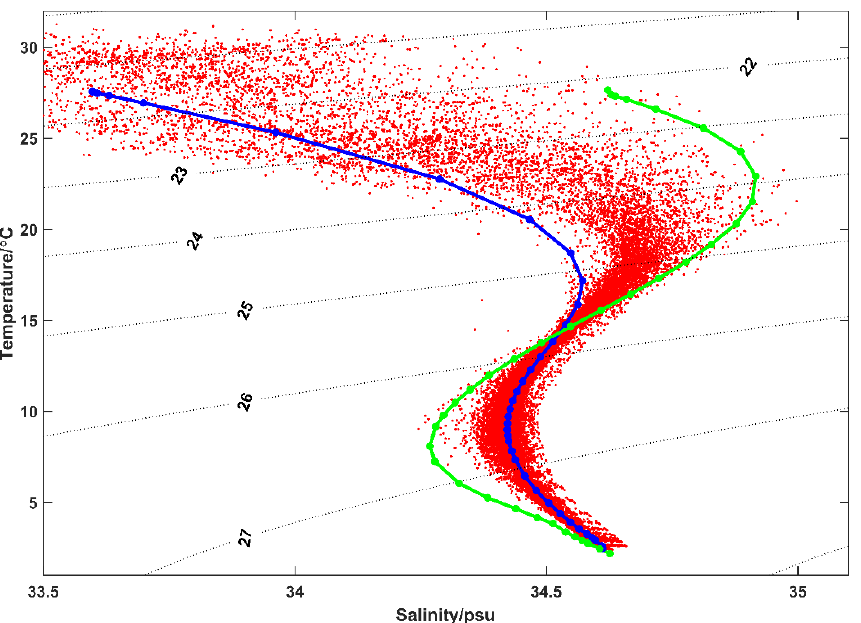
Figure 8. The T-S diagram of NPW, NSCS, and the H-Smax water. The blue and green dotted lines represent mean T-S values in NSCS and NPTW from Argo profiles (NSCS, 15 – 21° N 111 – 121° E;